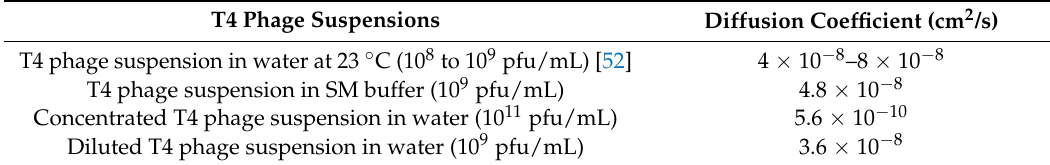
Table 1. Diffusion coefficient of phage T4 suspensions used in this